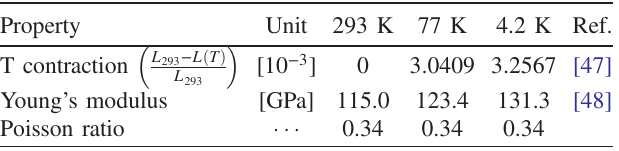
TABLE IX. Material properties of Cu.